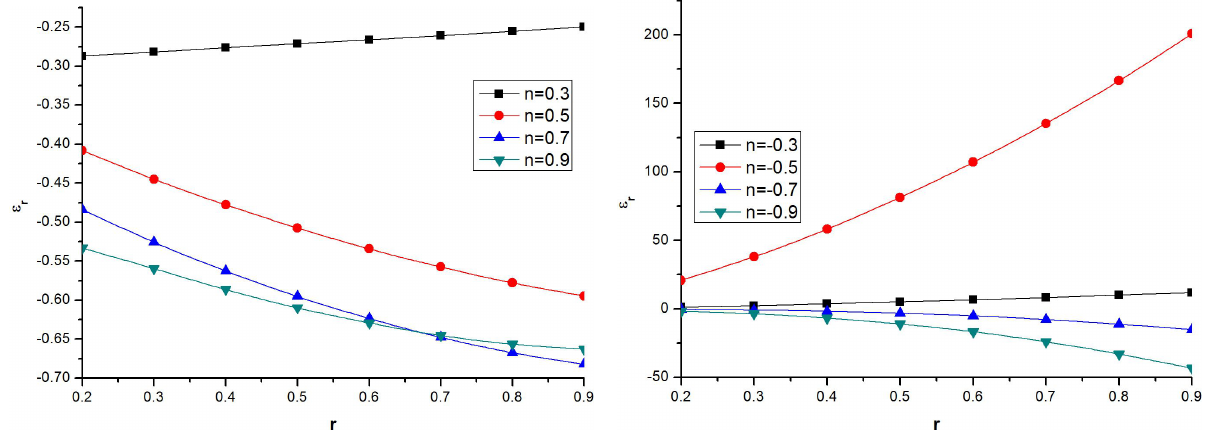
Figure 11: Radial strain versus radial coordinate for various values of n under steady state temperate